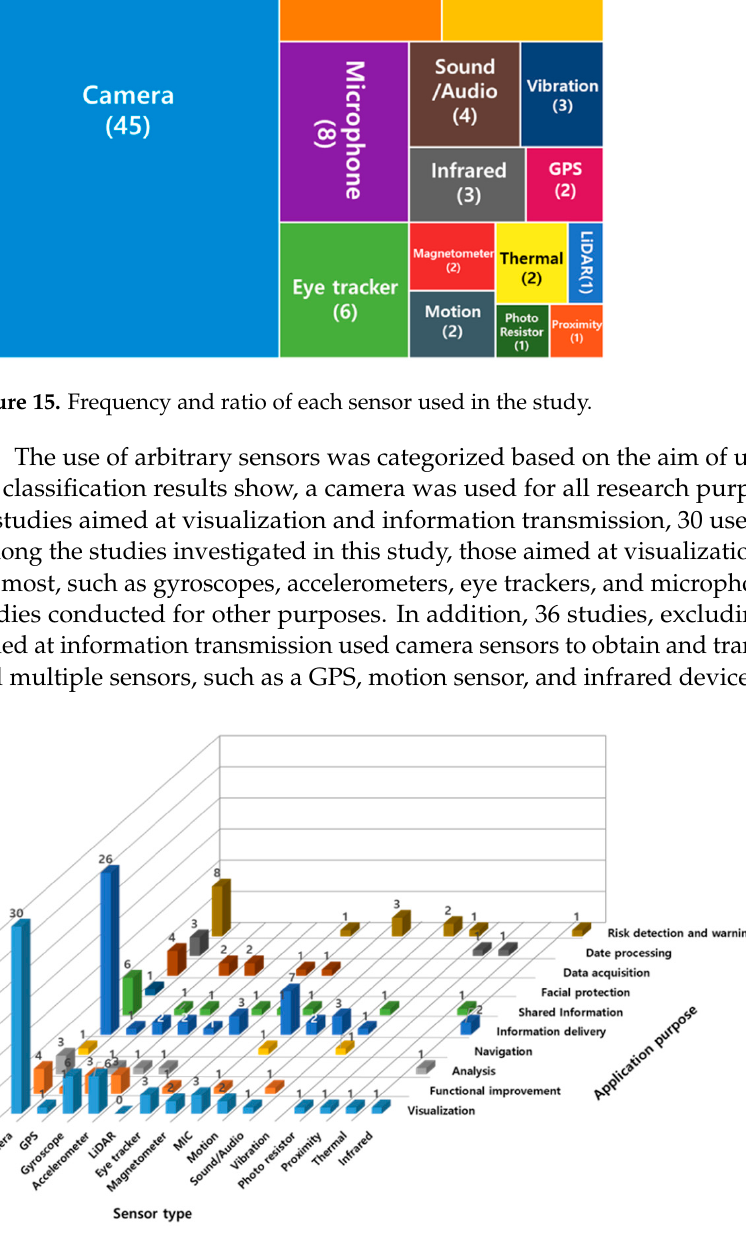
Figure 17. Use of sensors according to the purpose of using smart